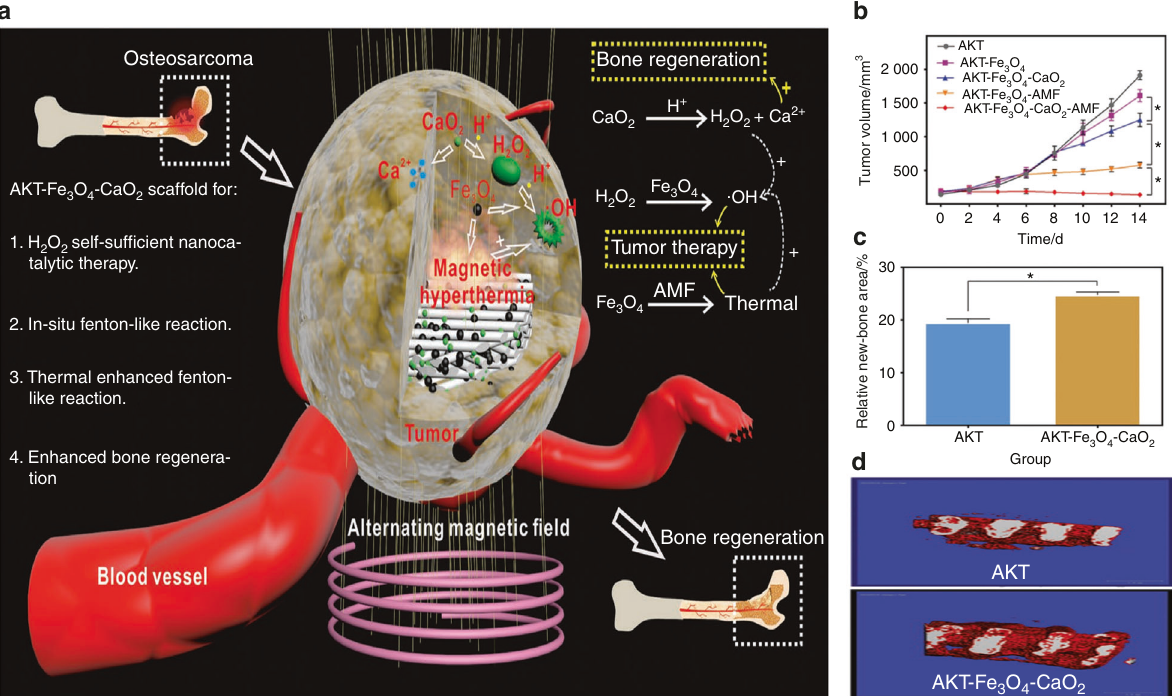
Fig. 5 3D-printing scaffolds coloading with Fe 3 O 4 and CaO 2 NPs (AKT-Fe 3 O 4 -CaO 2 ) for cancer therapeutic and bone regeneration. a Scheme of the fabrication of 3DP AKT-Fe 3 O 4 -CaO 2 scaffold with bifunction of magnetic hyperthermia and bone regeneration. b Time-dependent tumor- volume changes of mice after different treatment (* P < 0.05). c Quantitative analysis of newborn bone tissues after VG stained. d 3D reconstruction of micro-CT images showing the in vivo osteogenesis performance directly (red, newborn bone tissues; white, residual scaffolds). Reproduced with permission. 24 Copyright 2020,